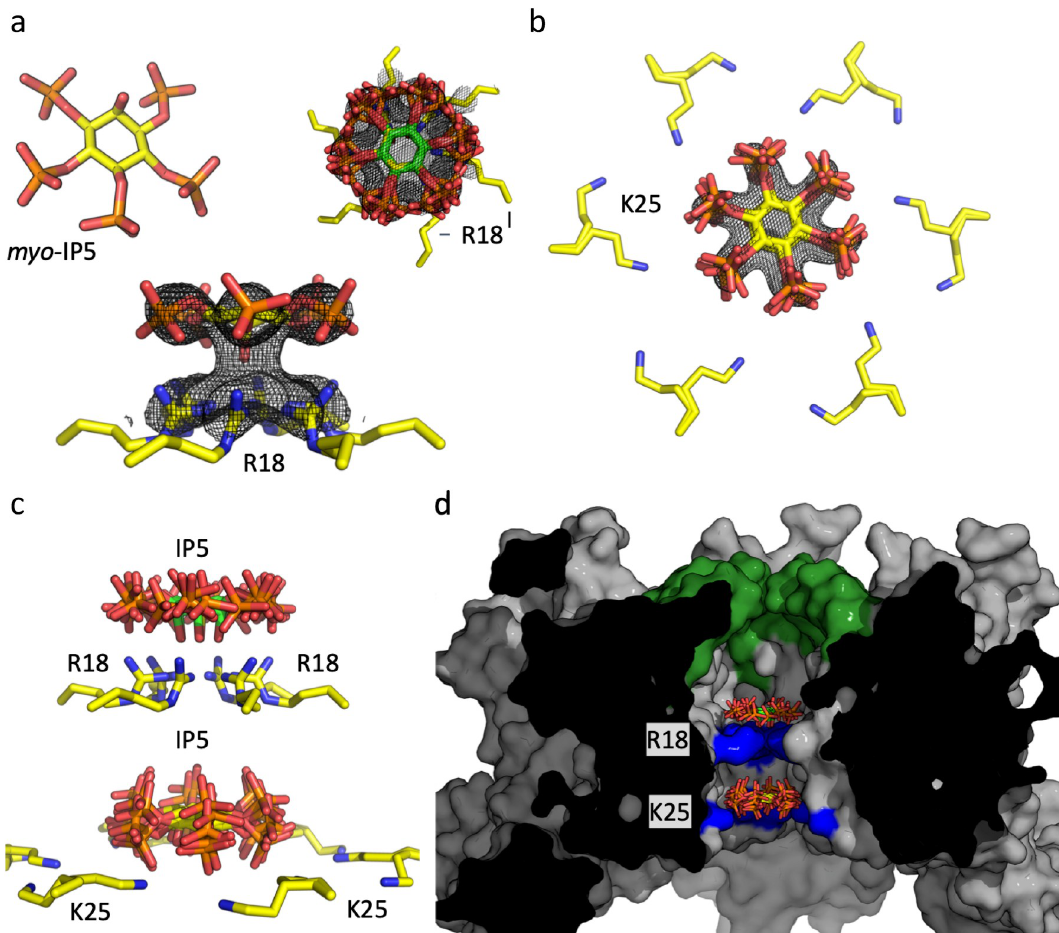
Fig 1. Structure of IP5 bound to HIV CA hexamer. (a) (left) Structure of myo-IP5 ligand. F o − F c omit density (mesh) contoured at 2.0 σ centered on IP5 bound to R18 and viewed down the 6-fold axis (right) and from the side (below). (b) F o − F c omit density (mesh) contoured at 2.0 σ centered on a second IP5 molecule next to K25 (two rotamer side chains are shown). All six-symmetry equivalent IP5 molecules are shown. (c) View showing the two IP5 molecules, one binding above R18 and one above K25. Note the second IP5 molecule is located closer to the K25 ring than R18. (d) Cross section through the hexamer, showing the central chamber where the IP5 molecules are bound. The β -hairpin is shown in green and the location of R18 and K25 in blue.